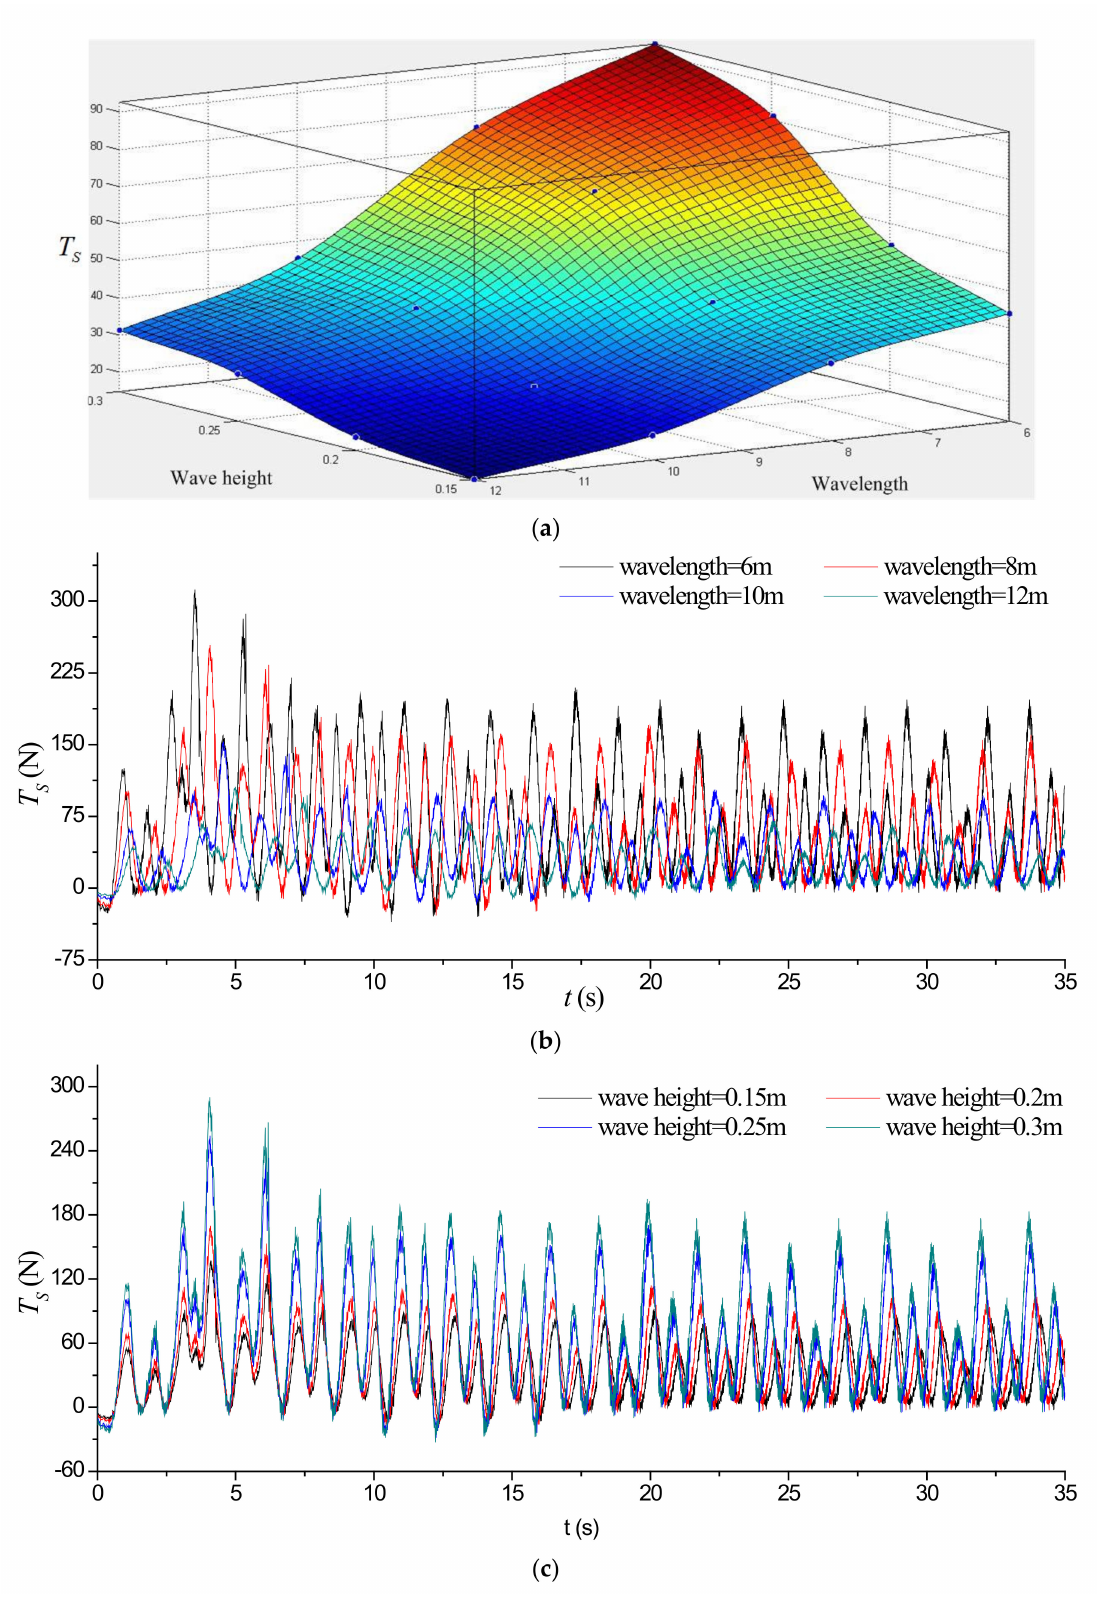
Figure 9. Under different wave parameters. ( a ) The curve of average values of T S under different wave parameters. ( b ) Variation curves of T S under different wavelengths when the wave height is 0.25 m. ( c ) Variation curves of T S under different wave heights when the wavelength is 8